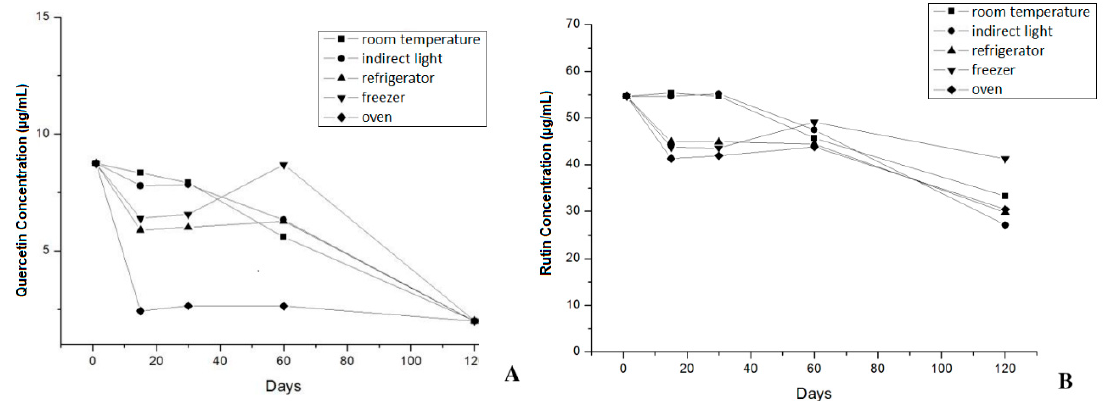
Figure 2. Quercetin concentration (µg/mL) ( A ) and Rutin concentration (µg/mL) ( B ) during stability study of phytocosmetic by HPLC method.